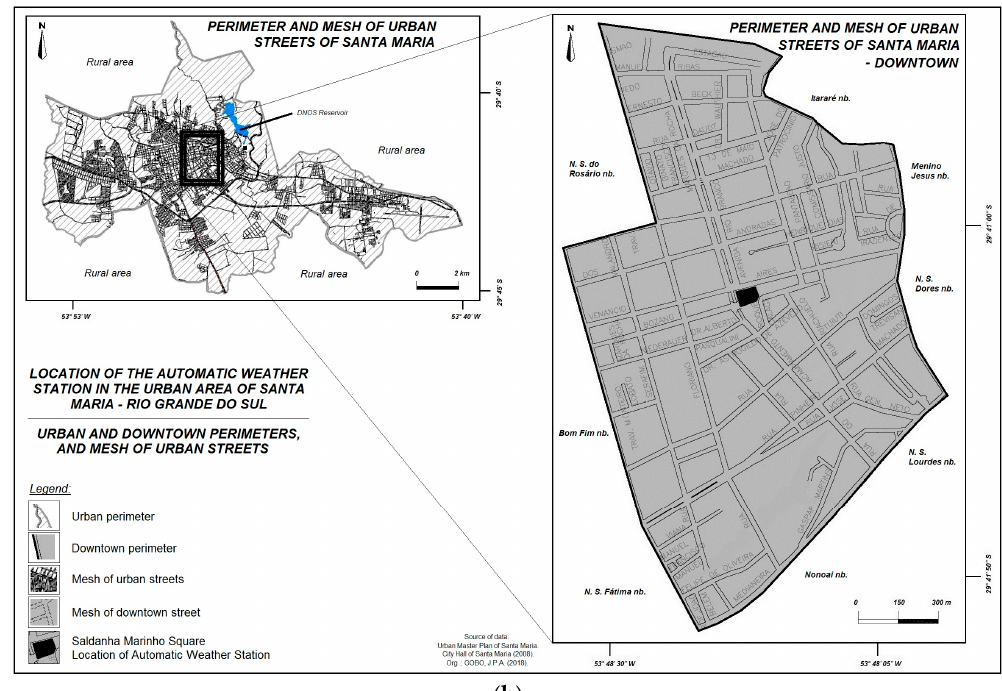
Figure 1. Location of the study area ( a ) and of the automatic weather station ( b ).